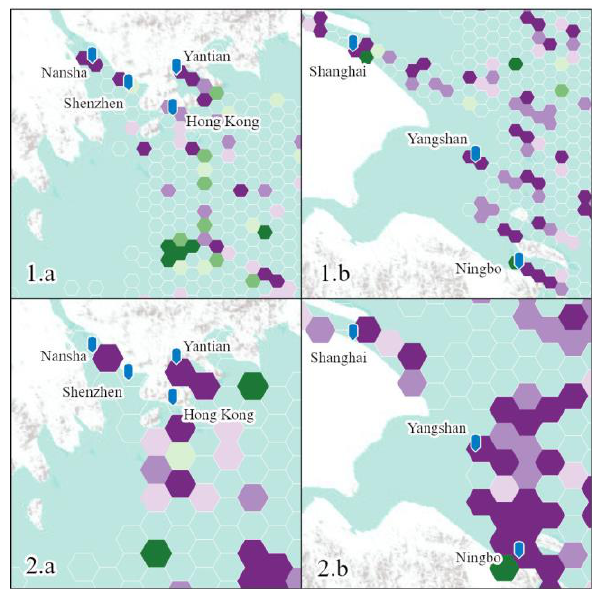
Figure 19 Trend analysis on counted AIS’ positions over all bin locations, for Hong Kong – Shenzhen (a) and Shanghai (b) areas. The height of hexagonal spatial grid change from 10 km